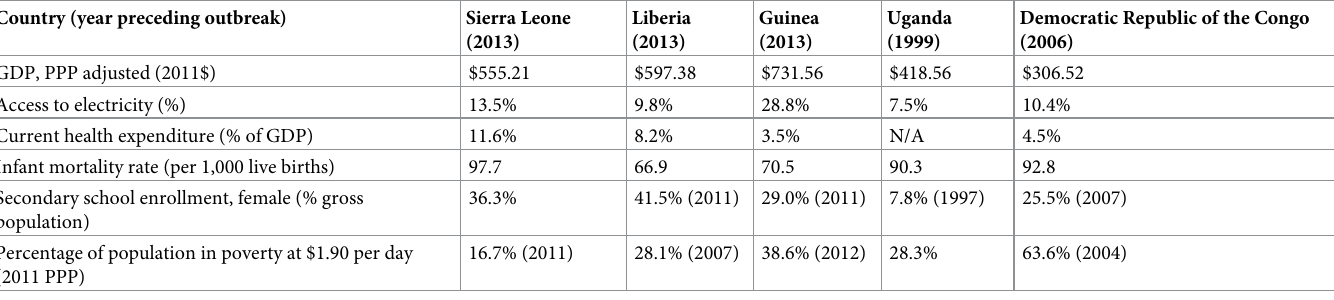
Table 1. Socioeconomic characteristics in year preceding outbreak, by country. Country (year preceding